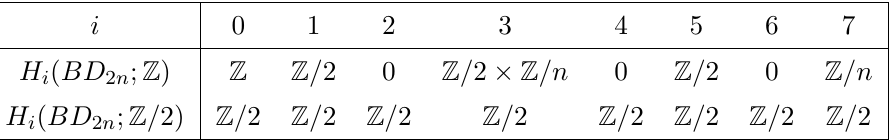
Table 8. Integral and mod 2 homology groups of BD 2 n with odd n .